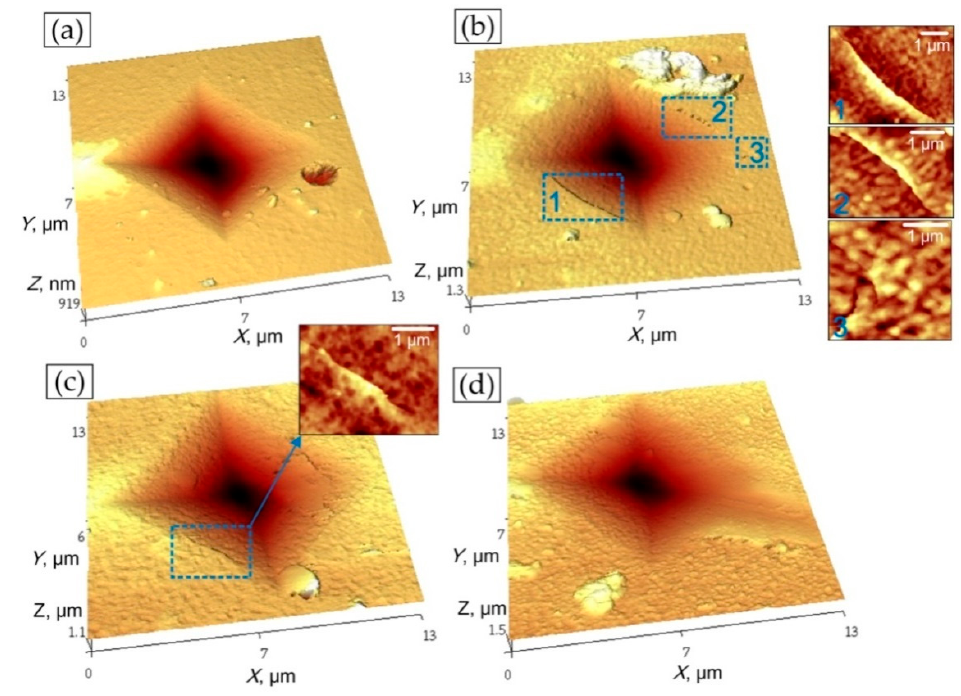
Figure 13. Pictures of failure after Vickers indentations: ( a ) Zr-O(0)-N, ( b ) Zr-O(10)-N, ( c ) Zr-O(50)-N, and ( d ) Zr-O(100)-N.